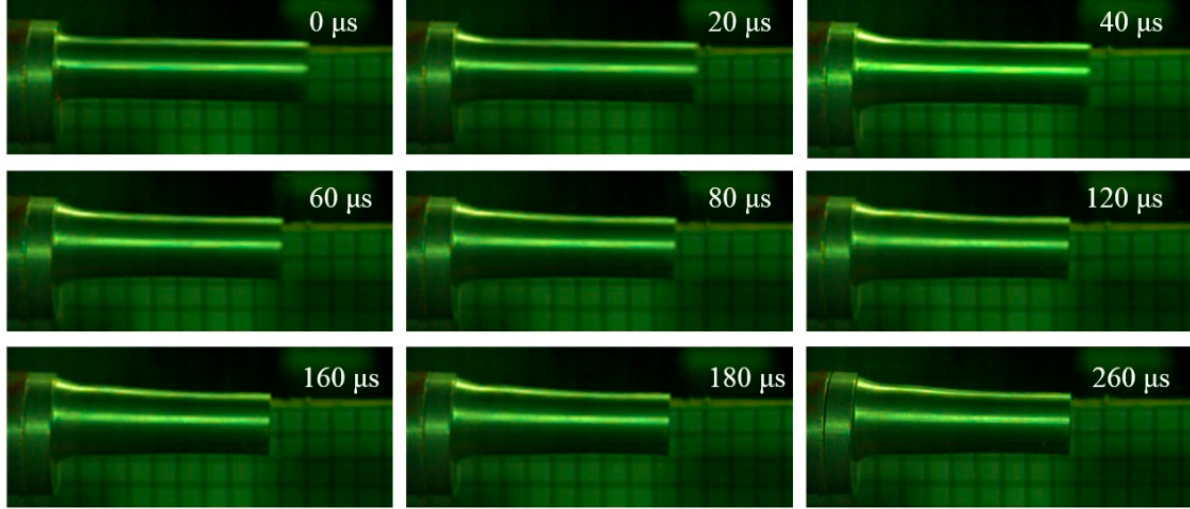
Figure 7. Series of high-speed photographs of the Taylor impact of the blunt projectile (171 m/s).